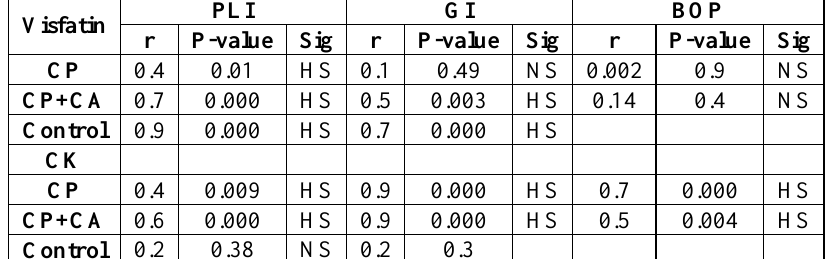
Table 5: Pearson's correlation coefficient (r) between visfatin and CK with periodontal parameters (PLI,GI,BOP).